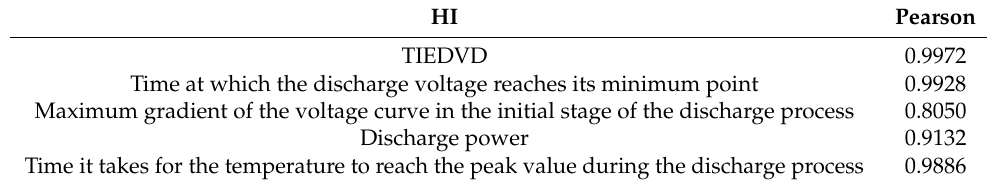
Table 4. Correlation analysis of HI and capacity of B0005.